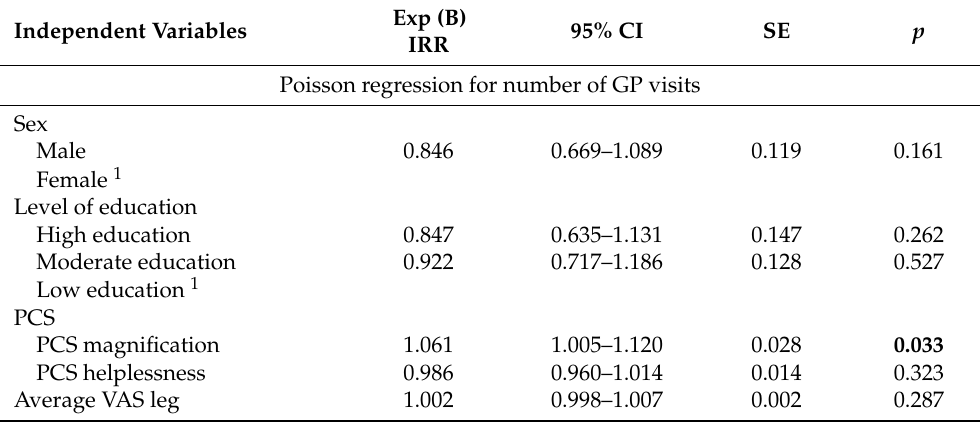
Table 4. Multivariable analyses for the association between HCU (number of GP visits and highest level of analgesics used) and demographics, pain intensity and